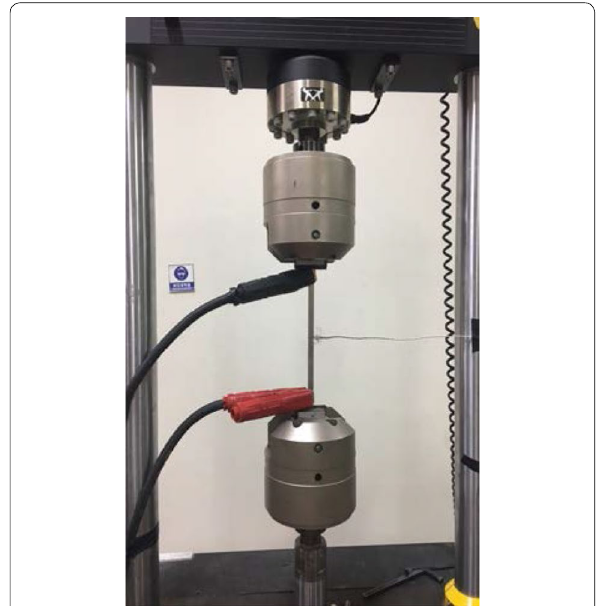
Fig. 3 Electric resistance heating of exposed Fe-SMA.